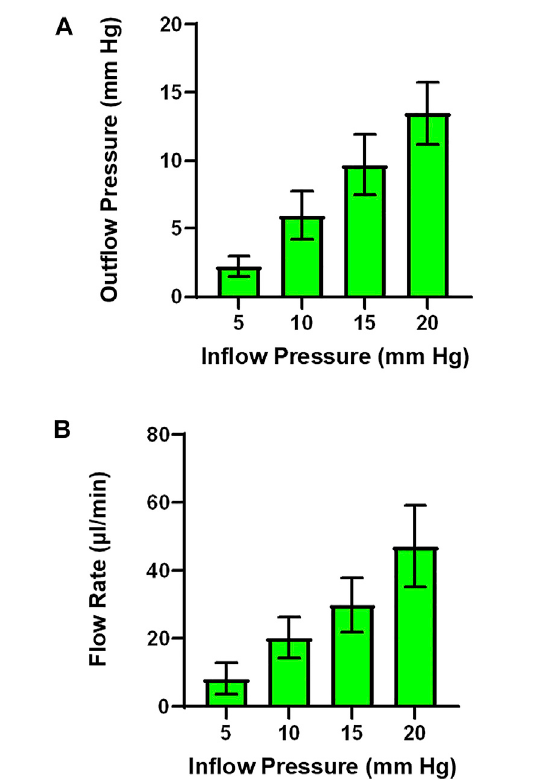
FIGURE 5 | Representative trace of placental fl ow. (A) Input (umbilical artery) perfusion pressure is increased in a stepwise fashion to measure placental resistance. (B) Output pressure is measured and a drop in pressure across the placenta is expected and indicative of placental health. (C) Alterations in placenta fl ow ( μ L/min) can be seen concomitantly with the change in in fl ow and out fl ow pressure, indicating placental resistance.